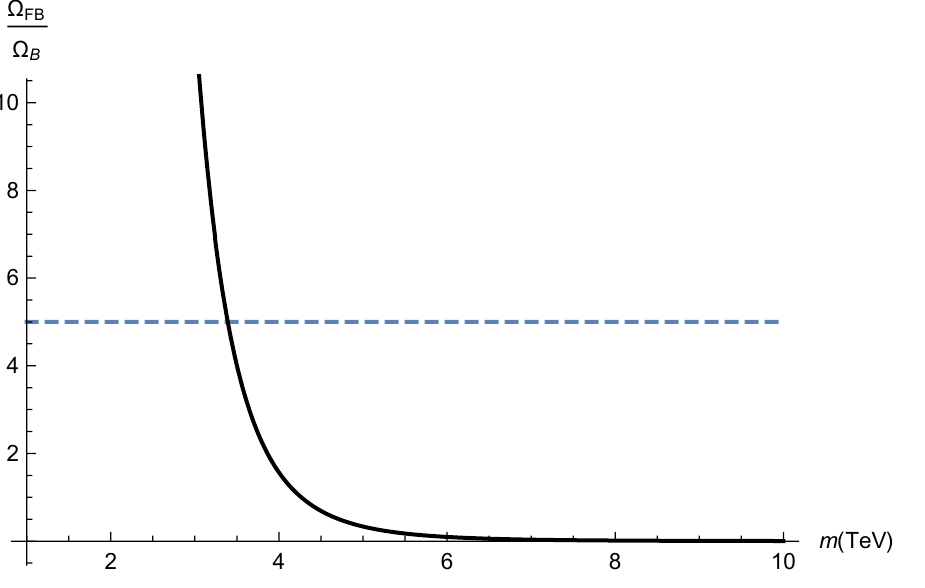
Figure 1. The ratio of dark matter and baryon densities as a function of the U-quark mass ( m ). This ratio is frozen out at the critical temperature of the assumed second order EWPT T = T c = 179 GeV. At the U-quark mass m ≈ 3.5 TeV, the predicted density of dark atoms, formed by ( ¯ U ¯ U ¯ U ) bound with primordial helium nuclei, can explain the observed dark matter